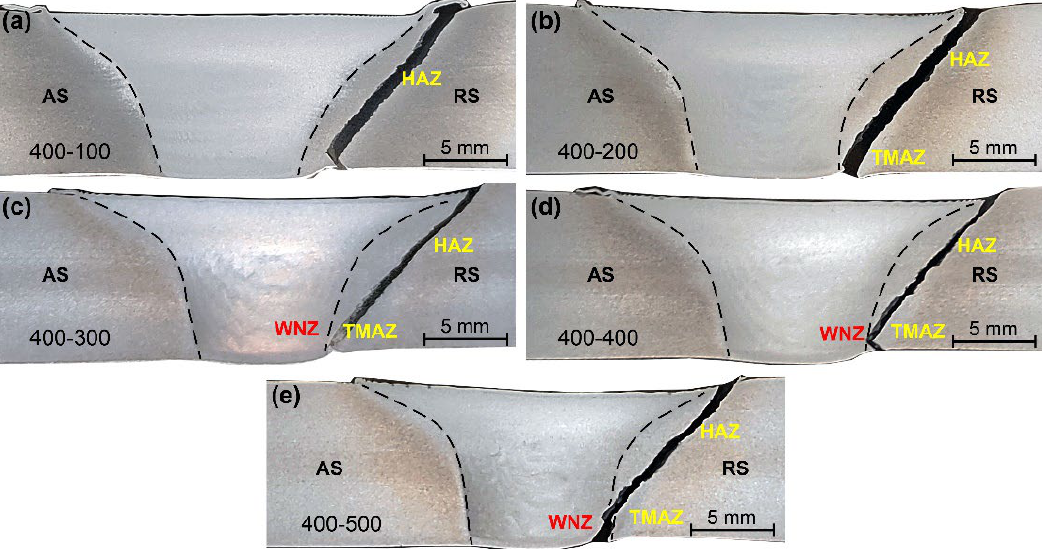
Figure 17. Fracture locations of joints by Pin-2 ( a ) 400-100, ( b ) 400-200, ( c ) 400-300, ( d ) 400-400, and ( e ) 400-500.